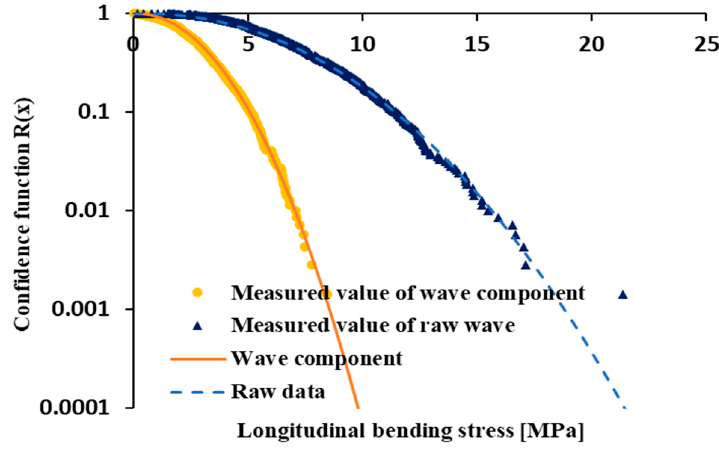
Figure 9. Time-series stress data of the vertical longitudinal bending component.